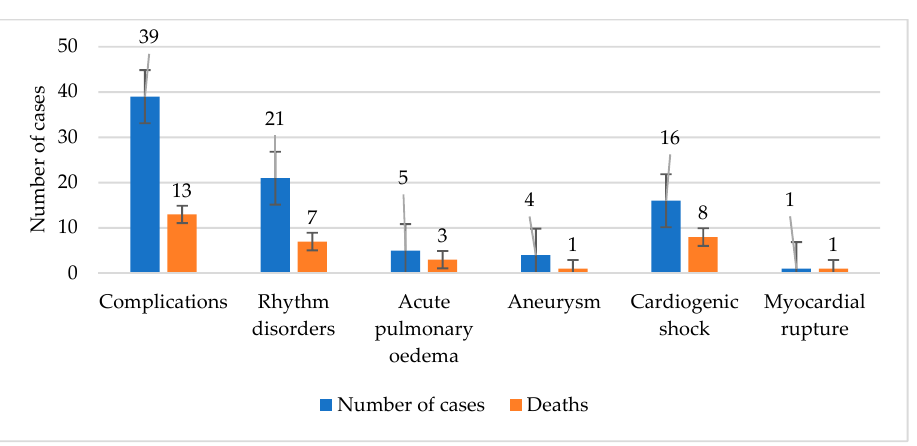
Figure 3. The dependence between the number of complications and the number of dead patients in the NRP+ group.